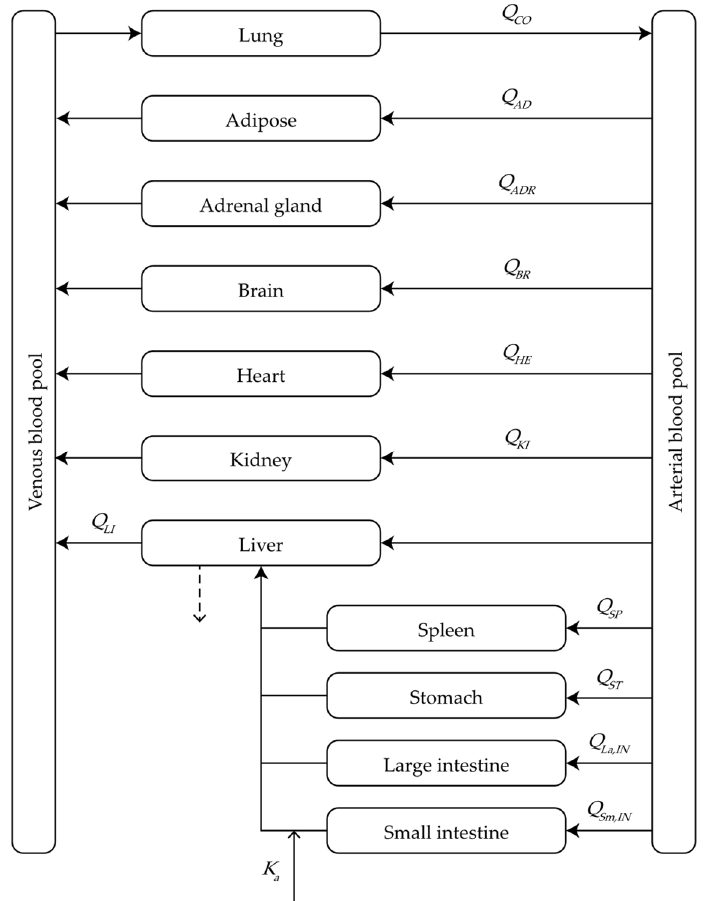
Figure 1. Physiological model of the pharmacokinetics of orally administered fexuprazan in humans. Table 1. Summary of physiological input parameters used for the PBPK model. The cardiac output